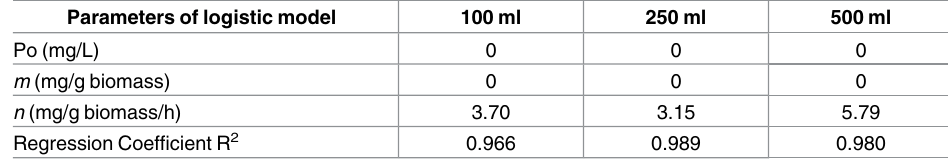
Table 4. Parameters defining the Leudiking and Piret model in shake flasks of L . theobromae strain 2334 of volumes of 100 mL, 250 mL and 500 mL and in the presence of KNO 3 as nitrogen source. Parametersof logistic